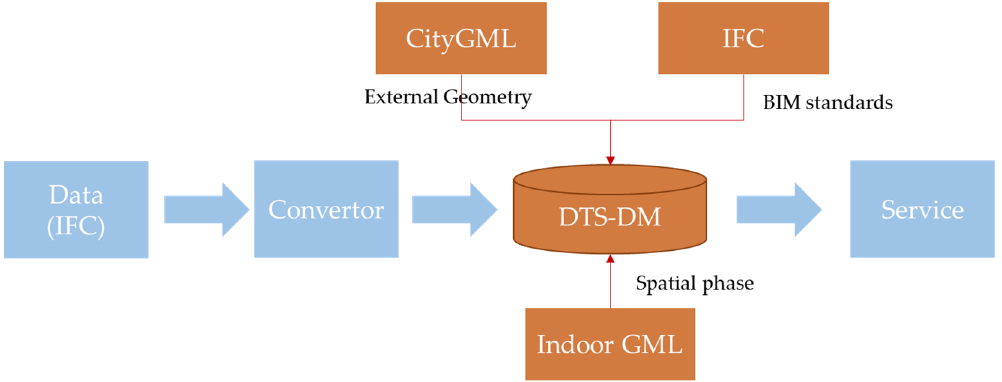
Figure 7. Underground utility tunnel DTS-DM conceptual model.